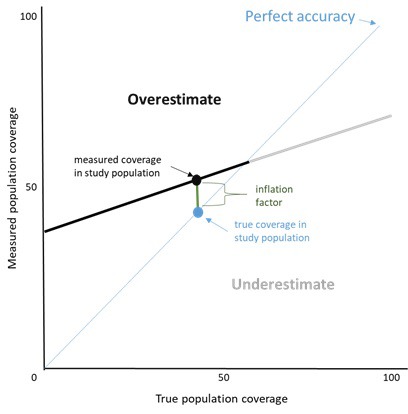
Inflation factor scatterplot.